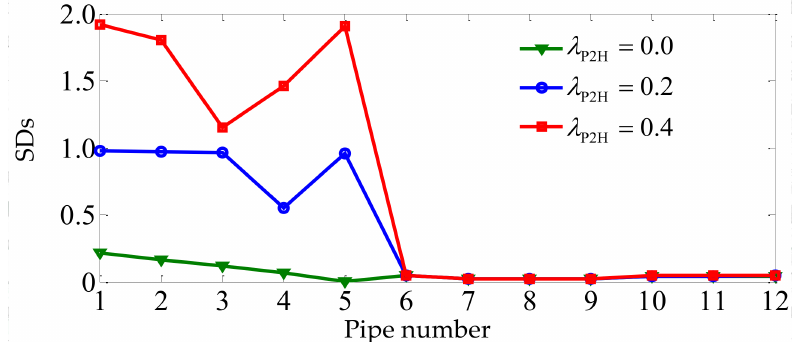
Figure 15. SDs of mass flow rates within pipes in the heating